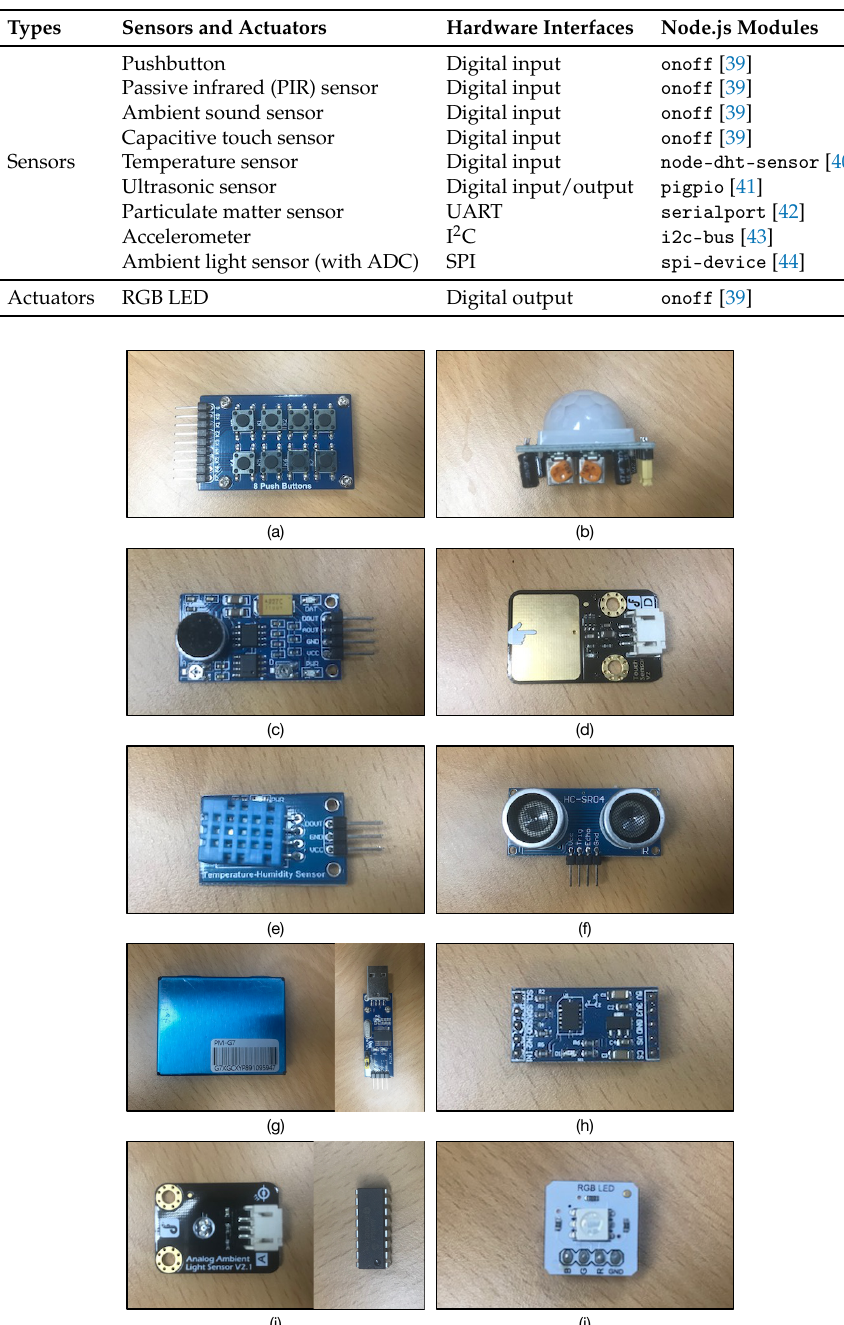
Figure 5. The photos of sensors and actuators deployed in our implementation work; ( a ) eight-pushbutton matrix, ( b ) passive infrared (PIR) sensor, ( c ) ambient sound sensor, ( d ) capacitive touch sensor, ( e ) temperature sensor, ( f ) ultrasonic sensor, ( g ) particulate matter sensor (left) with PL2303 USB-to-UART converter (right), ( h ) accelerometer, ( i ) ambient light sensor (left) with MCP3008 analog-to-digital converter (right), ( j ) RGB